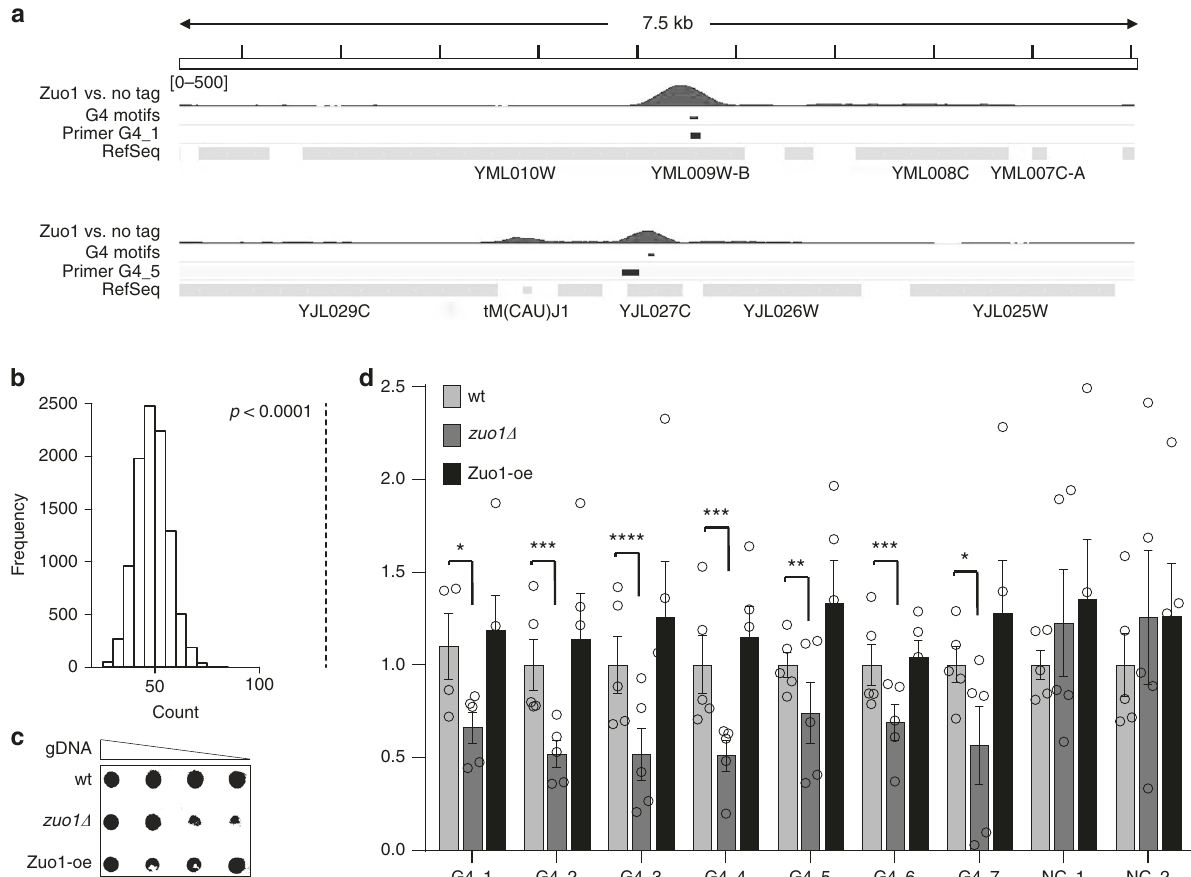
Fig. 2 Zuo1 binds G4 motifs genome-wide and support G4 formation. a IGV Genome Browser screenshot. Illustration of two 7.5 kb regions: top Chr XIII location 246,726 to 254,317 (G4_1) and bottom Chr X location 388,395 to 395,967 (G4_5). Zuo1-binding sites, location of G4 motifs and annotated genes are illustrated below. These regions were also among the regions tested in the qPCR, primers are indicated G4_1 and G4_5 (black track). b Genome-wide overlap of the Zuo1 peaks with G4 motifs as predicted by 4 . The black dotted line indicates a highly signi fi cant overlap p = 0.0001. c Southern – western combination to detect G4 structures in wildtype (wt), zuo1 Δ and Zuo1-oe cells. Different amounts of genomic DNA were spotted on a membrane (2, 1, 0.5, and 0.25 µ g), incubated with 2 µ g/ml of BG4 antibody and detected by chemiluminescence. d BG4-ChIP analysis followed by qPCR of G4 levels in wt, zuo1 Δ , and Zuo1-oe cells. Plotted are the means of n = 5 biologically independent experiments, which were normalized to wildtype. Error bars present ±SEM. Signi fi cance was calculated based on one-sided Student ’ s t -test. Asterisks indicate statistical signi fi cance in comparison with wildtype. * p <